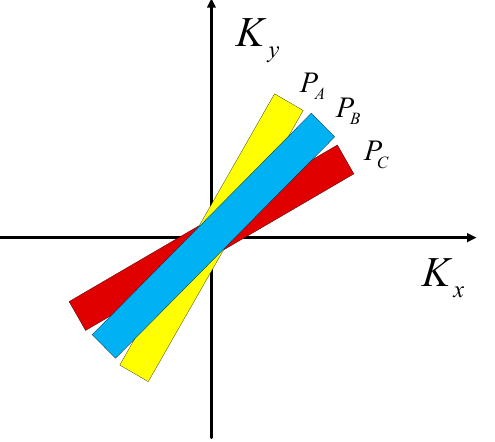
Figure 7. The 2-D wavenumber support region of the point A, B and C after the first step of spectrum compression.